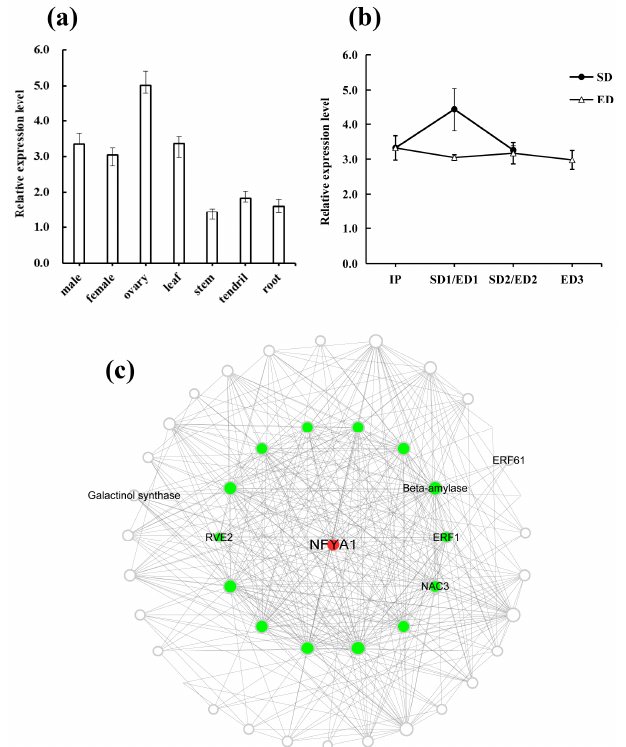
Figure 6. The verification of candidate gene CsaNFYA1 . ( a ) The expression patterns of CsaNFYA1 in multiple organs. ( b ) The expression patterns of CsaNFYA1 under different photoperiod regimes. ( c ) The co-expression network of candidate gene CsaNFYA1 according to the WGCNA results. CsaNFYA1 was labeled by the red circle. Fourteen genes established the directed co-expression relationship with CsaNFYA1 were marked by green circles. Other genes in the network were in white circles.